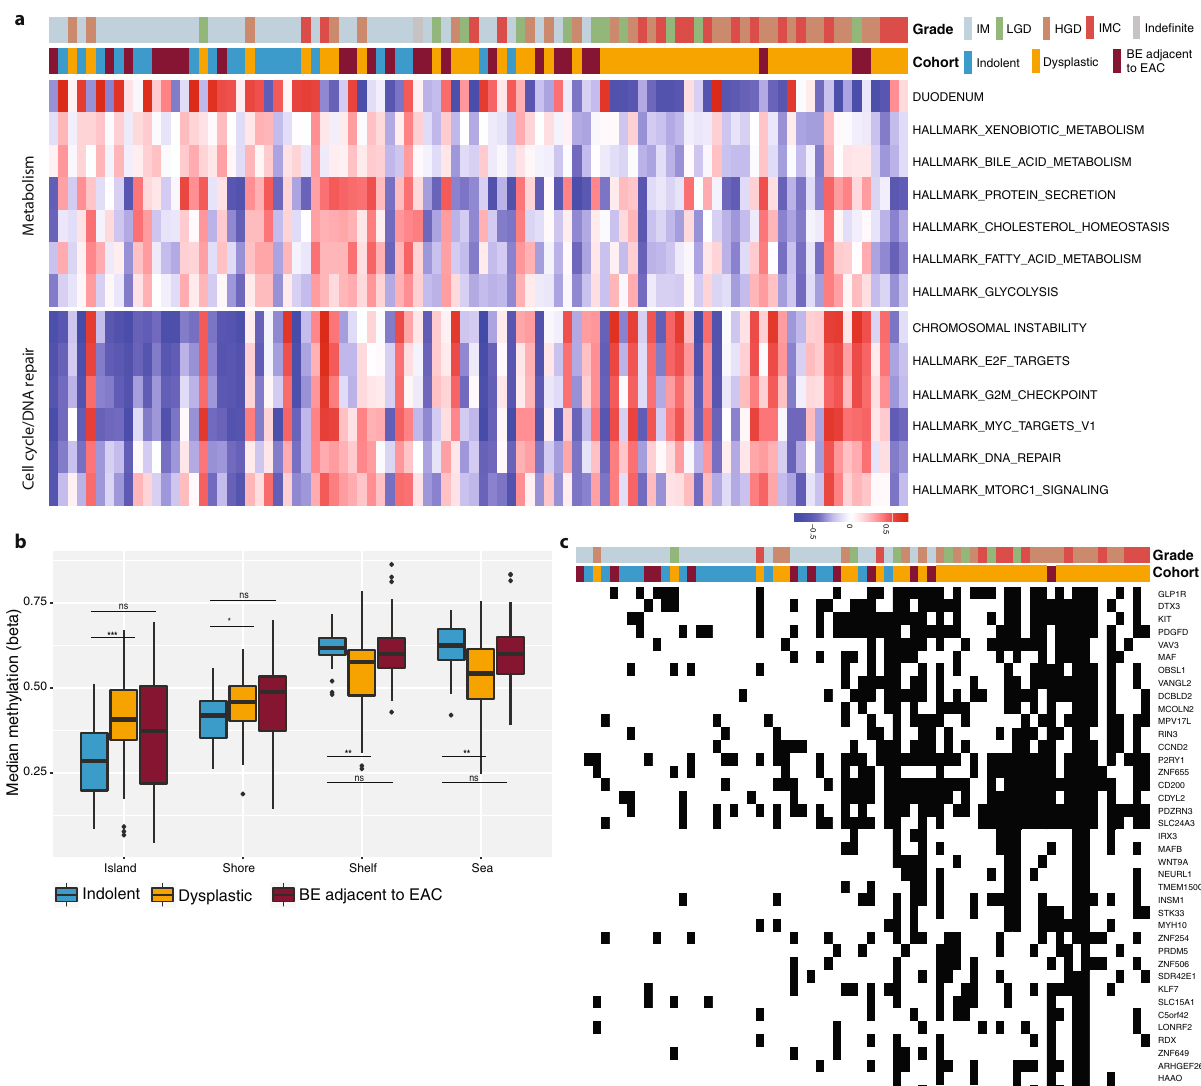
Fig. 4 Expression pathway and methylation analysis of the continuum. a Gene set enrichment analysis revealed the differential enrichment of genes involved in two main pathways, along the continuum: metabolism and cell cycle/DNA repair. Samples are ordered based on the SV continuum in Fig. 2, with highest patient grade and cohort group denoted at the top. b Median methylation levels for the cohort groups within different regions of the genome in relation to the CpG islands: island, shore (up to 2 kb from CpG island), shelf (2 – 4 kb from CpG island) and sea (>4 kb from CpG island). N = 100. Boxplot centre line denotes median, box limits are upper and lower quartiles, whiskers denote 1.5* the interquartile range. Statistical signi fi cance was calculated using Wilcoxon signed-ranked test. ns non-signi fi cant, * p -value < 0.05, ** p -value < 0.5, *** p -value < 0.001. c Integrated gene expression and methylation data. Patients are aligned along the same SV continuum order. Thirty-seven genes related to the Wnt signalling and cell cycle pathways for which altered expression followed a gain in promoter methylation and for which there was a signi fi cant change in expression with